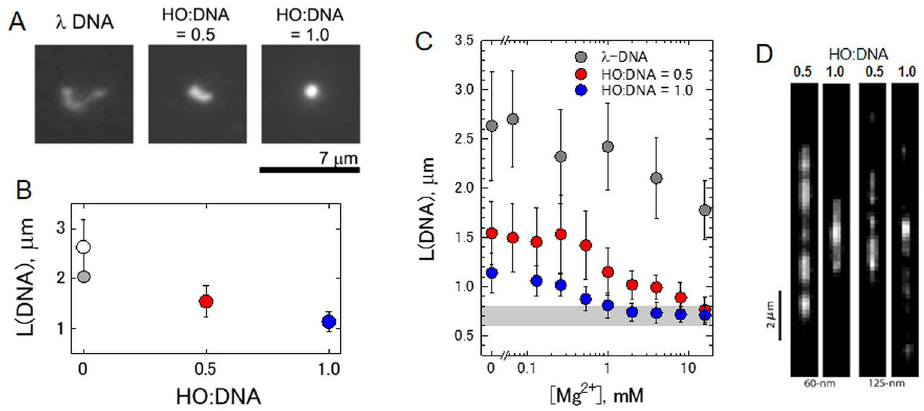
Figure 1. Fluorescence microscopy of reconstituted chromatin on λ-DNA show Mg 2+ -dependent compaction into dynamic clusters. ( A ). Typical fluorescence micrographs of a YOYO-labeled single λ-DNA molecule (left) and the nucleosome arrays reconstituted with 0.5 (center) and 1.0 (right) HO:DNA ratios. ( B ). Average long-axis length of λ-DNA and λ-DNA reconstituted with HOs as a function of a loading degree. The error bars indicate the standard deviations of the average values measured of ca. 100 individual DNA molecules or chromatin fibers. ( C ). Mg 2+ -induced compaction of λ-DNA and reconstituted nucleosome arrays. Changes in the average long-axis length of λ- DNA and nucleosome arrays at 0.5 and 1.0 HO:DNA ratios in the solution containing different concentrations of MgCl 2 . The error bars indicate the standard deviations of the average values measured of ca. 100 individual λ-DNA molecules or chromatin fibers. Shadowed areas indicate the long- axis length corresponding to the globular DNA conformation (0.6–0.8 μm). All solutions contain TE buffer with 100 mM NaCl. ( D ). Fluorescence still images of the λ-arrays in nanofluidic channels with HO:DNA ratios 0.5 and 1.0 in the 60-nm and 125-nm channels (see Supplementary Movies 1–4). OriginPro software 75 (http:// www. origi nlab. com) was used to create the graphs in ( B ) and ( C